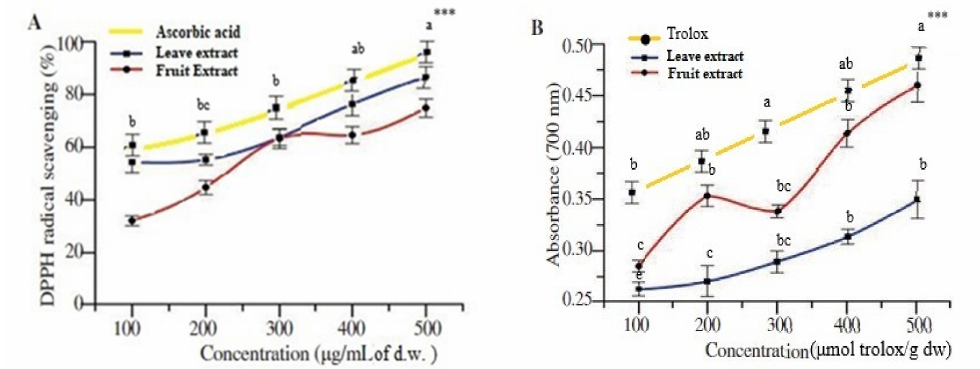
Figure 1. Antioxidant activity of A. marmelos leaves and fruit methanolic extracts. ( A ) DPPH free radical scavenging activity. ( B ) FRAP activity. Means in the same column not followed by a common letters are significantly different ( p < 0.05). *** = highly significant.